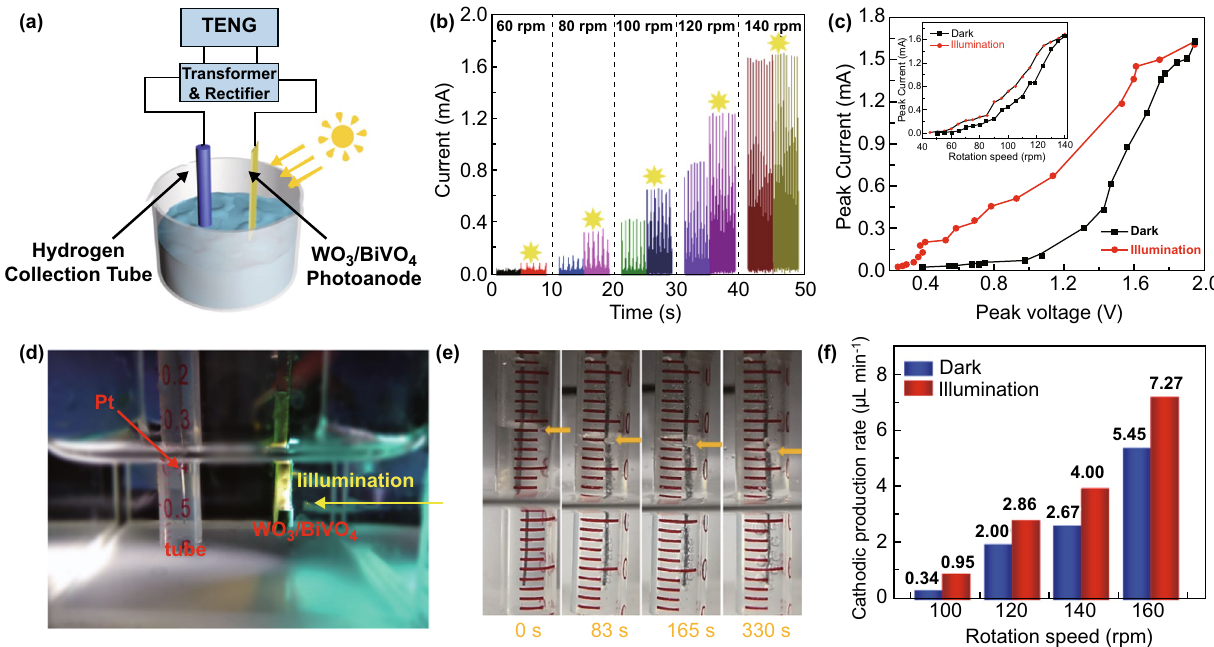
Fig. 4 Demonstration of hybridized mechanical and solar energy‑driven hydrogen production. a Schematic diagram of the self‑powered photo‑ electrochemical hydrogen generation system. b Current at various rotation speeds under darkness or illumination. c Relationship between peak voltage and peak current in darkness or light. Inset: peak current under different rotation speeds, dark and illumination. d A photograph of the H 2 collection tube was used to collect hydrogen under illumination. e Optical images of the H 2 collection tube at the different times in a phosphate buffer (0.5 M, pH = 7) including Na 2 SO 3 (1 M) as hole scavenger. f Hydrogen generation rate at four different rotation speeds in darkness or